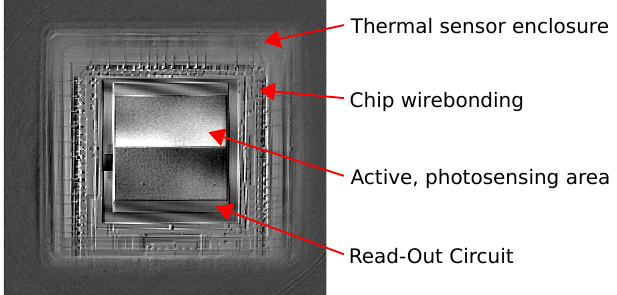
Figure 3. Thermal image of Micro80 detector array, made with a microscopic thermal